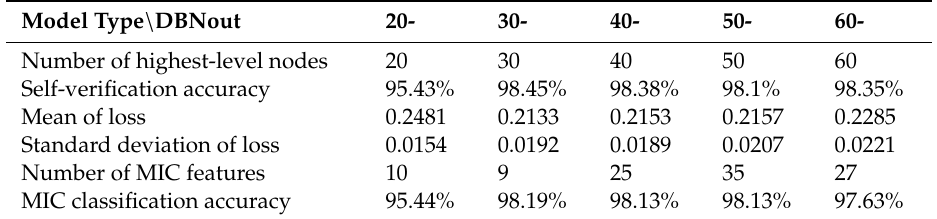
Figure 8. Trend of classification accuracy with different top ‐ level features. Table 3. Identification e ffi ciency before and after the MIC processing at di ff erent numbers of high-layer neurons in DBN. Table 6. Identification efficiency before and after the MIC processing at different numbers of high ‐ layer neurons in DBN.